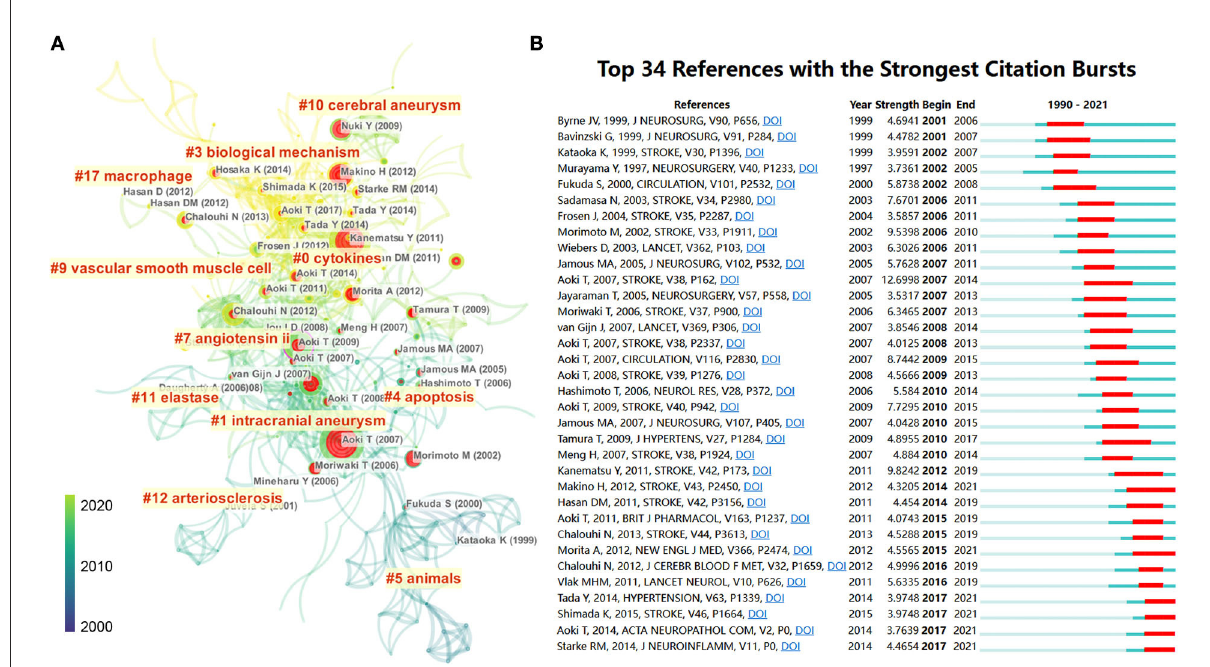
FIGURE6 (A) Reference co-citation network identified by CiteSpace. The nodes and links are distinguished by colors, in which blue reflects an earlier co-citation relationship, and yellow represents a recent co-citation relationship. The size of nodes is positively associated with the citation number. The red nodes represent the publication has burst change, which may connect authors in different sub-domains in a given field. (B) The 34 most co-cited references with the strongest citation bursts represent important publications in different periods. The red bar indicates the burst duration. The burst strength indicates the importance of the research